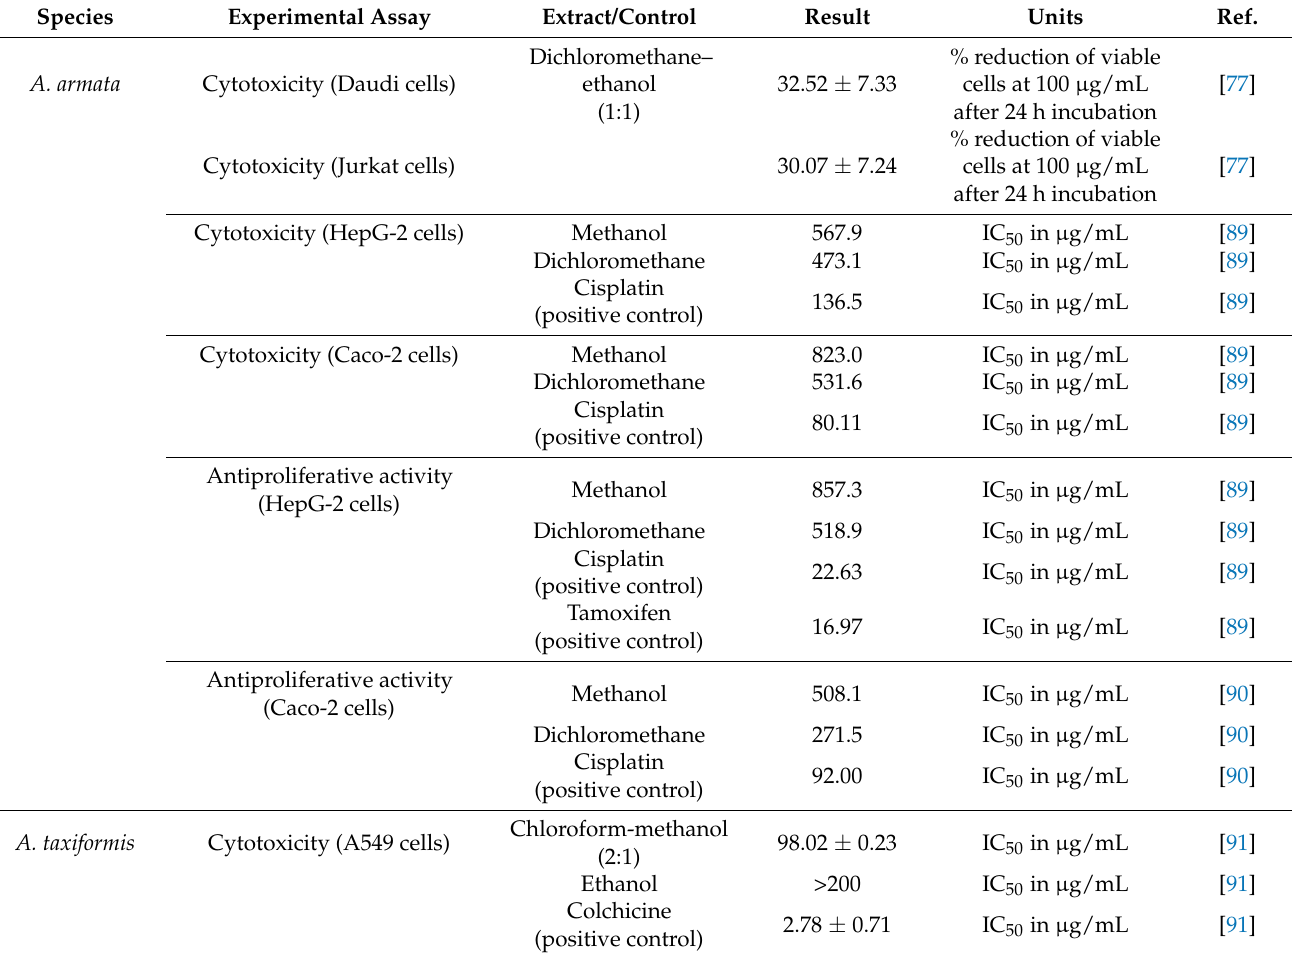
Table 2. Anticancer activity of Asparagopsis